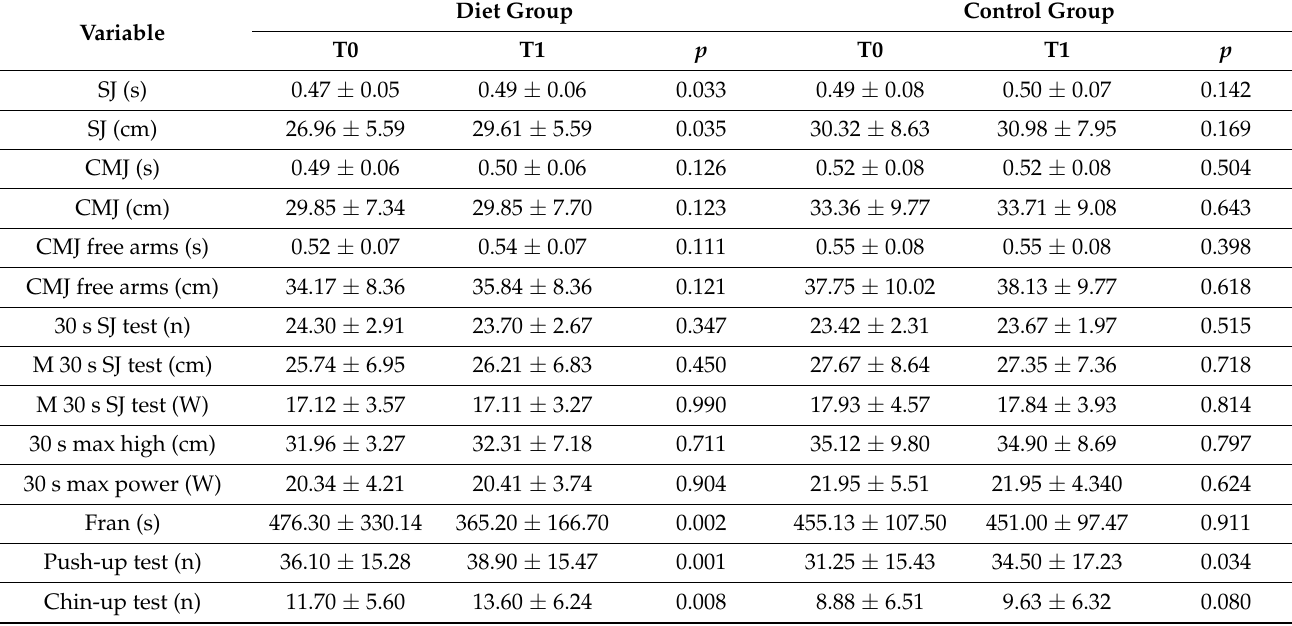
Table 4. Results of jump tests and CrossFit